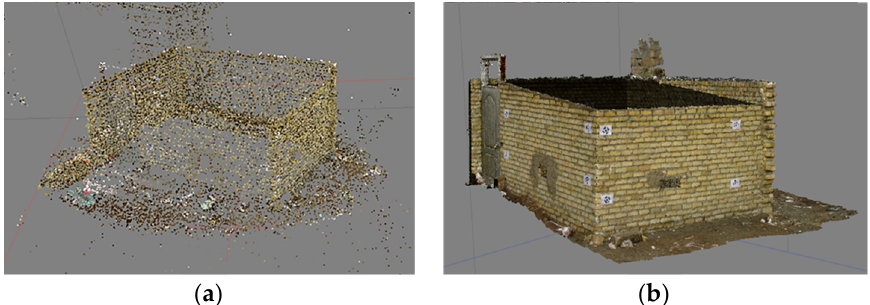
Figure 4. Generated point could for the first case study: ( a ) The sparse point cloud, ( b ) the dense point cloud.